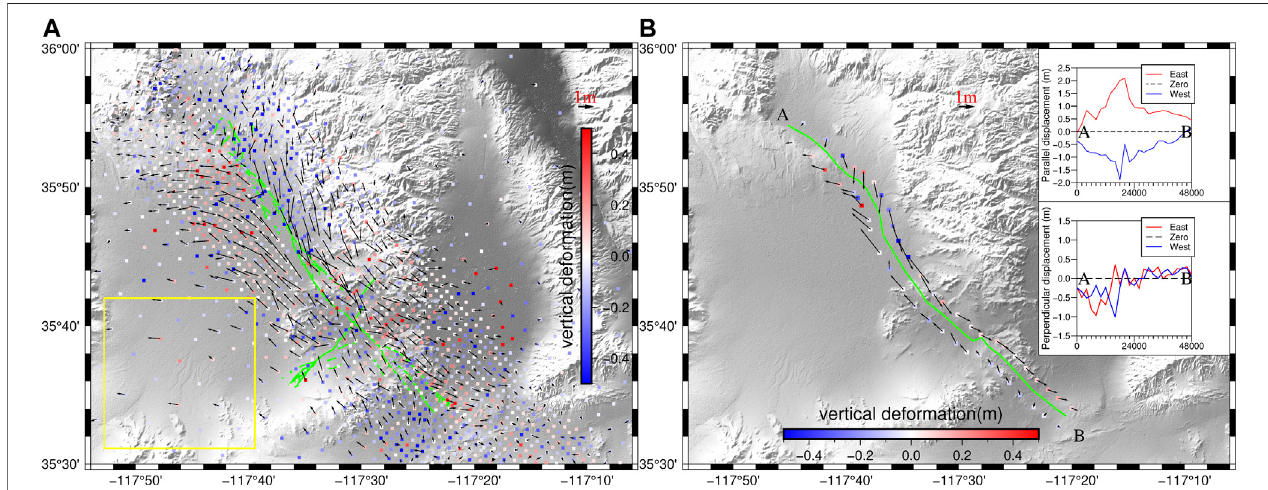
FIGURE 3 | Three-dimensional (3D) coseismic displacements in the Ridgecrest region. Colored squares indicate the vertical displacements, and black arrows representthedirectionandmagnitudeofthehorizontaldisplacements.Theareaenclosedbyayellowrectangleischosenforaccuracyevaluationassumingverysmooth coseismic deformation. The standard deviation of measurement points within the yellow rectangle is 0.11, 0.13, and 0.12 m along the east – west, north – south, and up – downdirections,respectively. (A) Greenlinesshowthesurfacerupturesofthe2019Ridgecrestsequence(Brandenbergetal.,2019). (B) Thegreenlineshows thesimpli fi edNW – SEmainrupturethatwemappedaccordingtothecoseismicinterferogram,phasegradientmap,andpixeloffsets( SupplementaryFiguresS1 – S3 ). The inset shows the decomposed displacements parallel and normal to the main rupture.